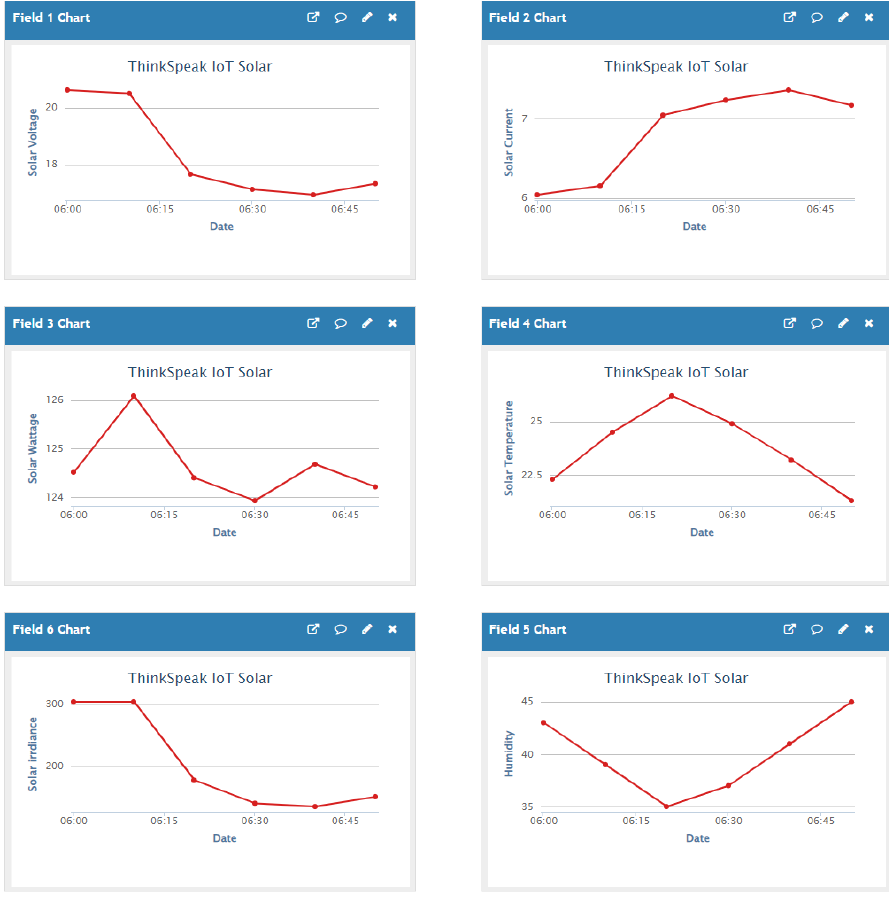
Figure 13. Real-time results for three active and two shaded PV modules.